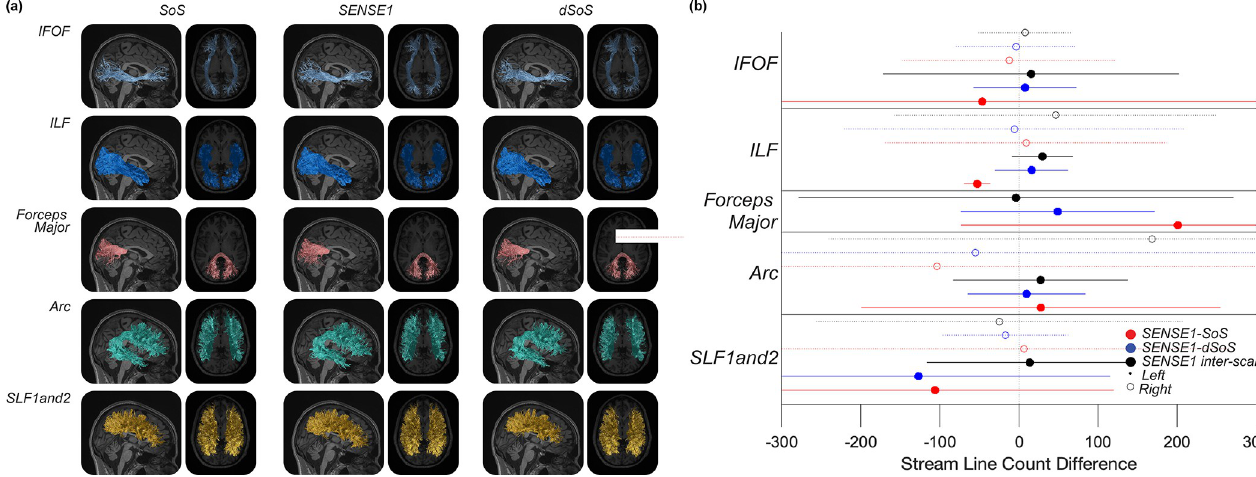
Fig 7. The difference in the number of tractography streamlines between SENSE1 and SoS, SENSE1 and dSoS, and SENSE1 repetitions for nine bundles: IFOF (left and right), ILF (left and right), Forceps Major, Arc (left and right), and SLF 1 and 2 (left and right). The x-axis is the average difference in streamline count between the comparison (i.e., SENSE1-SoS (red), SENSE1-dSoS (blue), SENSE1-SENSE1 repeat (black)). The error bars represent 90% confidence